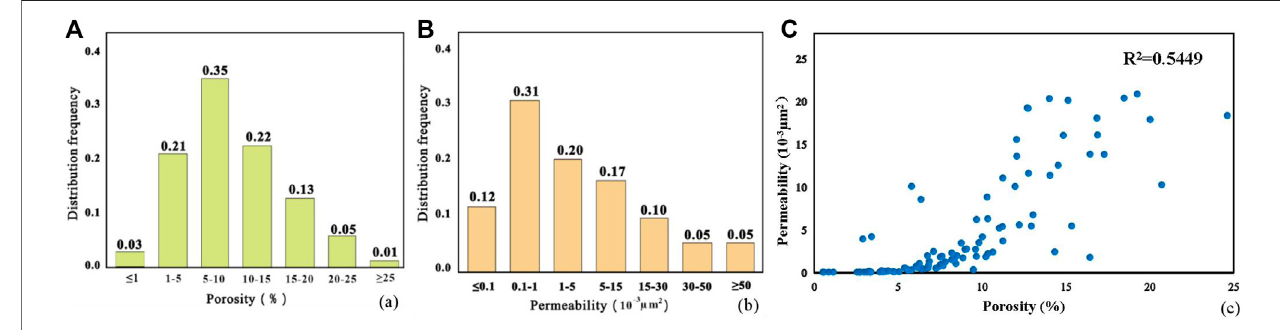
FIGURE 4 | Physical characteristics of FSR reservoirs. (A) Histogram of porosity distribution frequency; (B) histogram of permeability distribution frequency; (C) intersection fi gure of porosity and permeability.